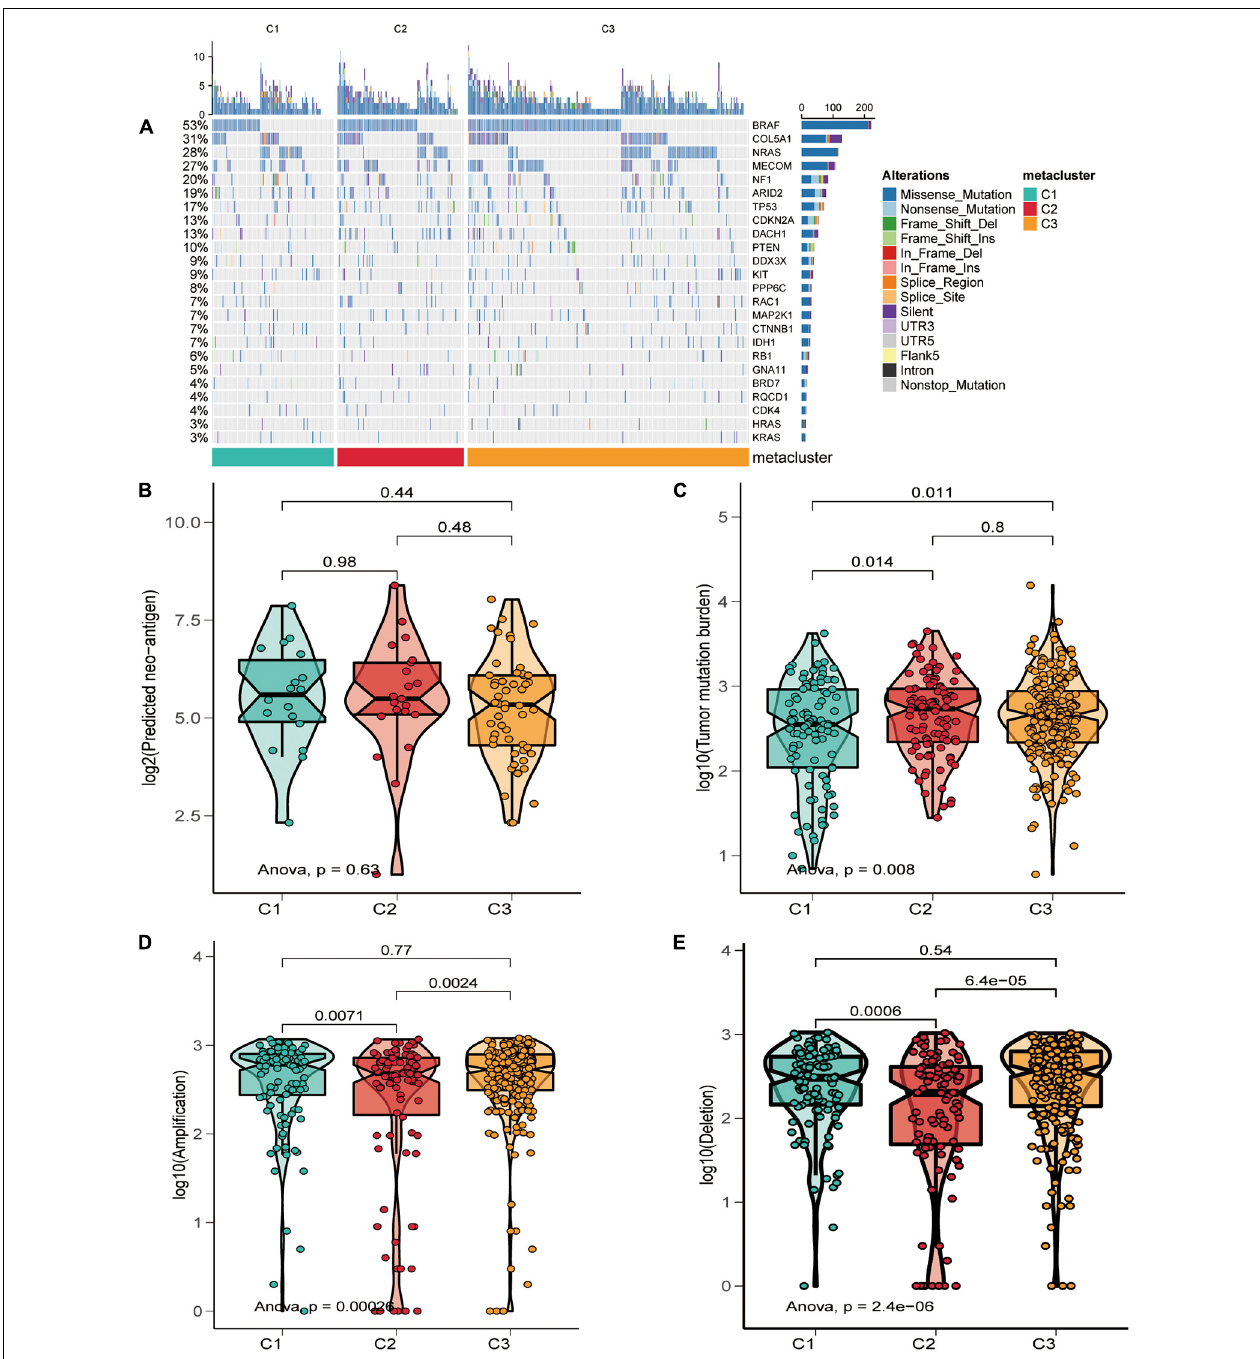
FIGURE 5 | Relationship of SKCM subtypes with tumor mutation burden characteristics. (A) Driver-type oncogenic mutations based on TCGA-SKCM typing with intra-group aggregation waterfall plots. (B–E) Violin plots of the number of mutation-predicted neoantigens (B,C) and copy number aberrations (D,E) box lines for SKCM subtypes. Wilcoxon rank-sum test was used to compare statistical differences (ns indicates not